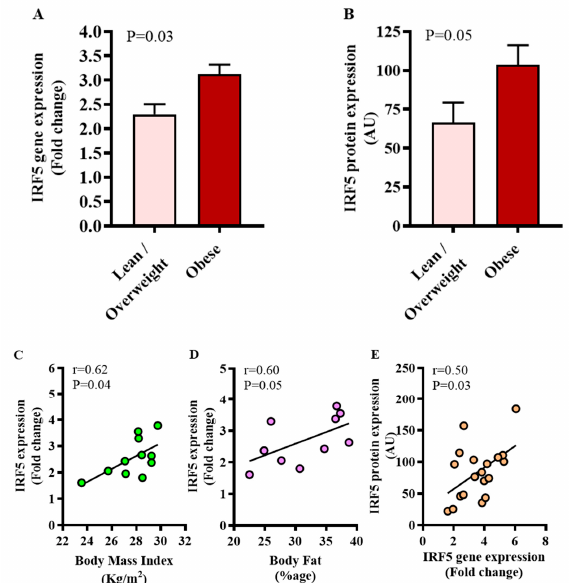
Figure 1. Increased adipose tissue interferon regulatory factor (IRF)5 expression in diabetic obese patients. IRF5 gene expression was assessed in the adipose tissue by using qRT-PCR in 46 type-2 diabetic (T2D) patients and expression of the IRF5 protein was determined by immunohistochemistry (IHC) in 19 T2D patients as described in materials and methods. Regarding qRT-PCR, GAPDH gene expression was used as internal control. The expression level of IRF5 gene relative to control (lean adipose tissue) was calculated by using 2 −ΔΔ Ct method and expressed as relative mRNA expression or fold change over the average control expression taken as 1. Regarding IHC, IRF5 protein staining intensity, expressed as arbitrary units (AU), was determined by using Aperio-positive pixel count algorithm and ImageScope software. The number of positive pixels was normalized to total pixels (positive and negative) and color / intensity thresholds were set with immunostaining as positive and background as negative pixels. The data (mean ± SEM) show significantly elevated ( A ) IRF5 gene expression (fold change) ( p = 0.03) and ( B ) IRF5 protein expression (AU) ( p = 0.05) in diabetic obese compared to diabetic lean / overweight patients. Furthermore, in diabetic lean / overweight subjects (11), IRF5 gene expression was found to associate positively with ( C ) body mass index (BMI: r = 0.62, p = 0.04) and ( D ) %age of body fat ( r = 0.60, p = 0.05). ( E ) Overall, IRF5 gene and protein expression were found to be mutually concordant ( r = 0.50, p =